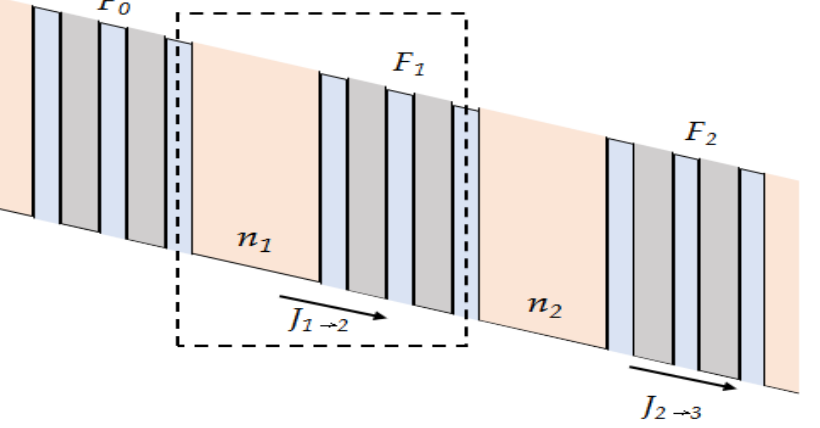
Figure 2. Energy diagram of three well structures of QCL(current densities J m , electron densities n m and fields F m , module number m).